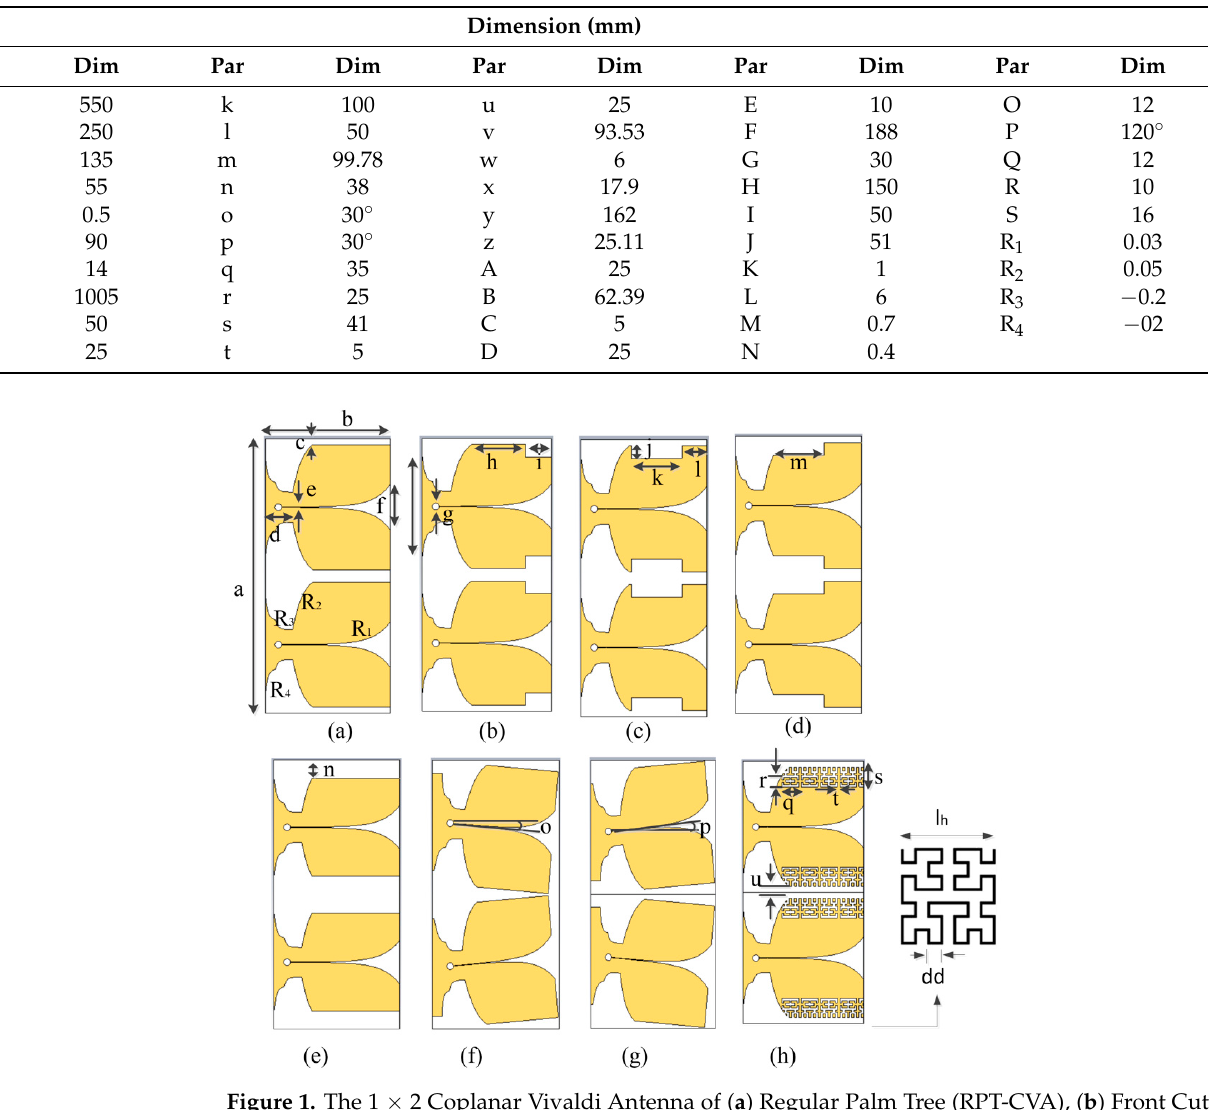
Figure 1. The 1 × 2 Coplanar Vivaldi Antenna of ( a ) Regular Palm Tree (RPT-CVA), ( b ) Front Cut Palm Tree (FCPT-CVA), ( c ) Middle Cut Palm Tree (MCPT-CVA), ( d ) Back Cut Palm Tree (BCPT-CVA), ( e ) Complete Cut Palm Tree (CCPT-CVA), ( f ) Left Tilt Palm Tree (LTPT-CVA), ( g ) Right Tilt Palm Tree (RTPT-CVA), ( h ) Hilbert Fractal Structure Palm Tree (HFSPT ‐ CVA).